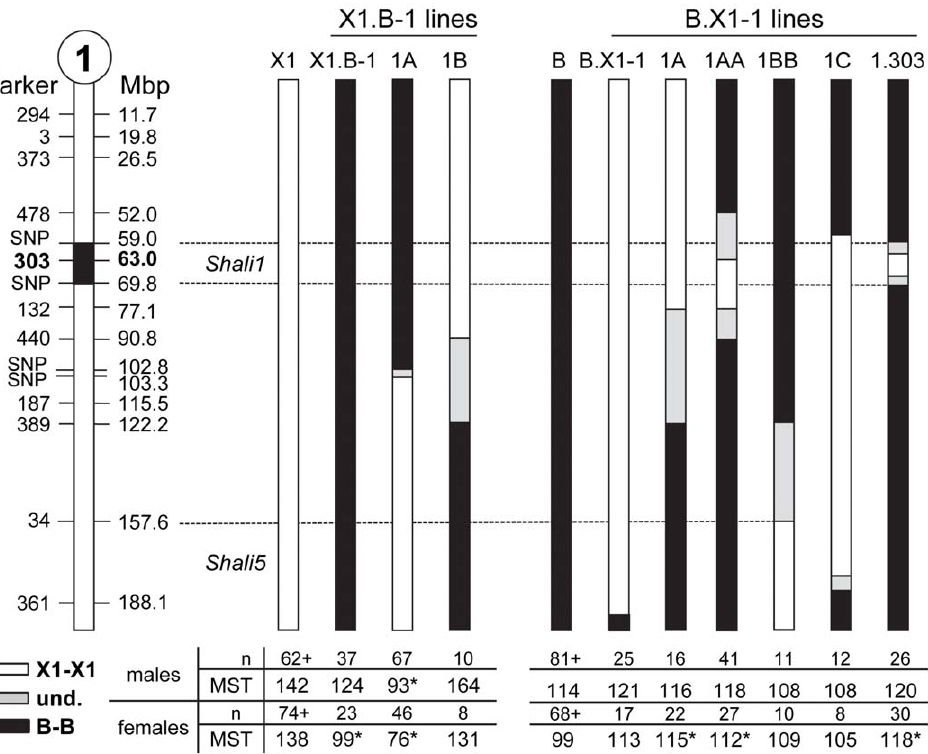
Figure 3. Schematic summary of the reciprocal X1.B-1 and B.X1-1 consomic, congenic and subcongenic lines for Shali1 . Data represent chromosome 1 of each strain, with X1 (solid white bar) and B (solid black bar) representing the recipient background strain of X1.B-1 and B.X1-1 lines, respectively. Chromosome 1 on the far left depicts MIT markers and positions (Mbp), along with the putative Shali1 interval (black box). The current validated Shali1 and Shali5 intervals are indicated by dashed lines. X1.B-1 and B.X1-1 represent reciprocal consomic lines (full chromosome substitution). For X1-B-1 lines (left half), regions in black denote the substituted chromosome region, including the congenic lines X1.B- 1A and X1.B-1B. For B.X1-1 lines (right half), regions in white represent the substituted regions. B.X1-1A and B.X1-1C are congenic lines and B.X1-1AA and B.X1-1BB are subcongenic lines of B.X1-1A and B.X1-1B (died), respectively. B.X1-1.303 was derived from a rare double recombinant identified early the screening process and fixed after removing all donor regions outside of the , 11-Mbp area around marker D1Mit303 . Grey regions